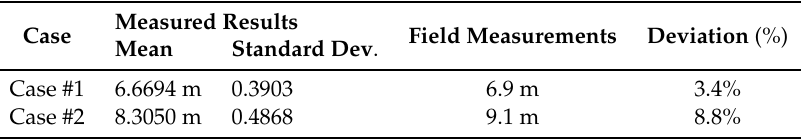
Figure 14. Cumulative erosion over the summer of 2017 in Case #2. The wind speed data are shown in subfigure ( a ). Using the storm surge module, the surge levels are calculated (subfigure ( b )). With the inundation depth, h id calculated in subfigure ( c ), the erosion is calculated accordingly (shown in subfigure ( d )). The crest retreat is calculated for n = 1000 cases in the Monte Carlo simulation. The outcome of the global model is one thousand calculated crest retreat values which follow a normal distribution. The mean erosion is drawn as a thick black line with ± 1.96 σ drawn as dotted lines to show how the uncertainty of the prediction increases over time. Table 5. Summary of erosion in the two